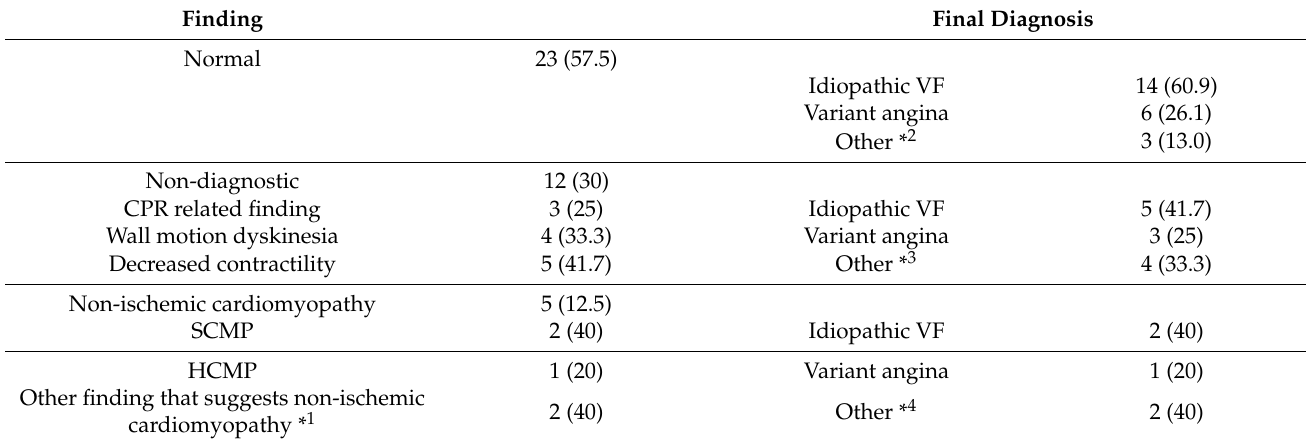
Table 3. Cardiac magnetic resonance imaging findings and final diagnosis in study